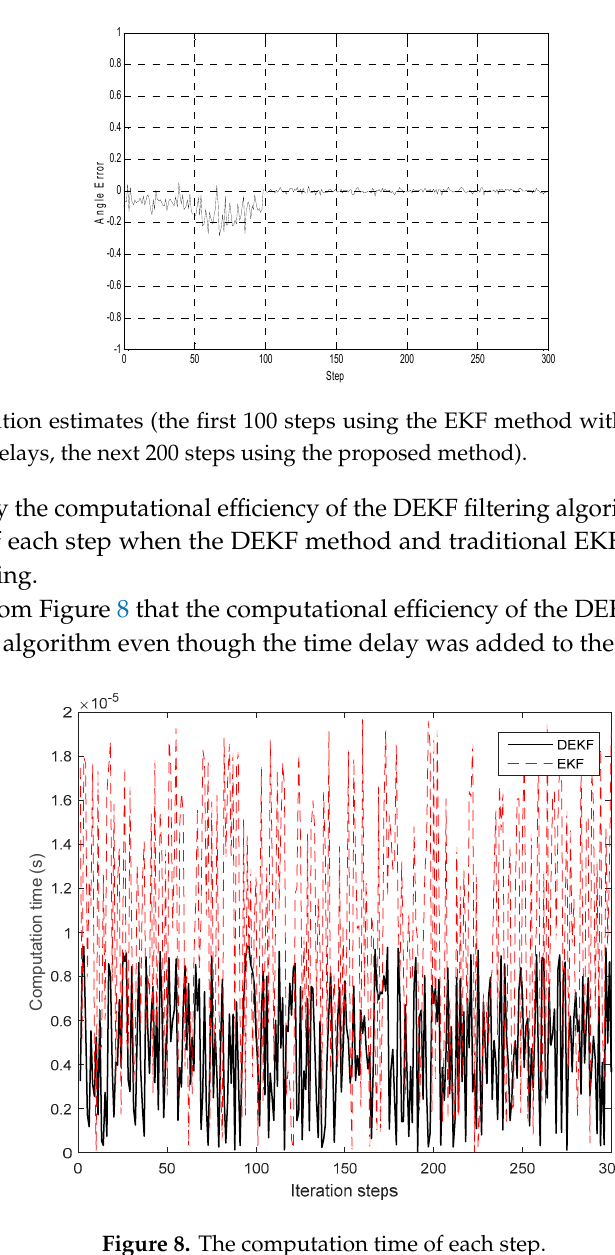
considering the communication delays, the next 200 steps using the proposed method).